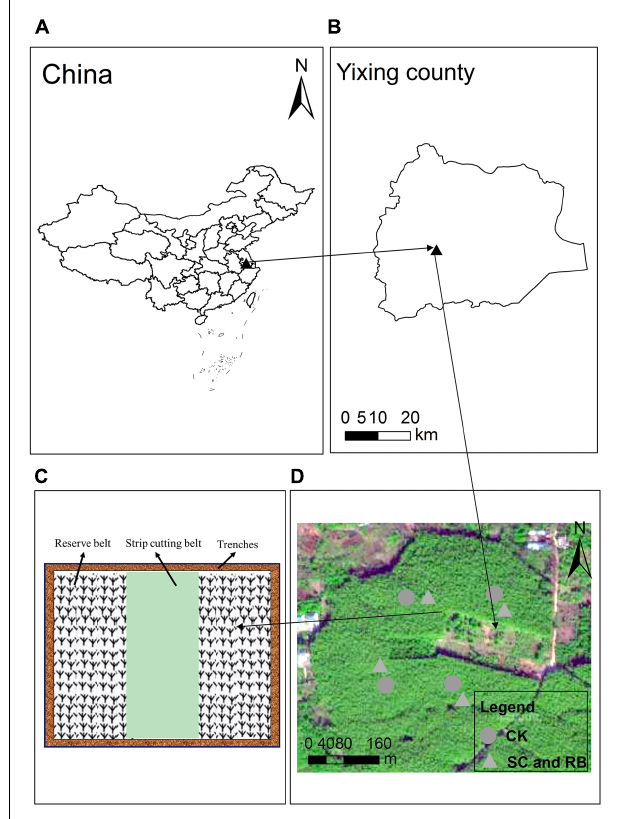
FIGURE 1 | Location of the study area (A,B) and field experiment design (C,D) and sampling sites (SC, RB, and CK) Moso bamboo forests.